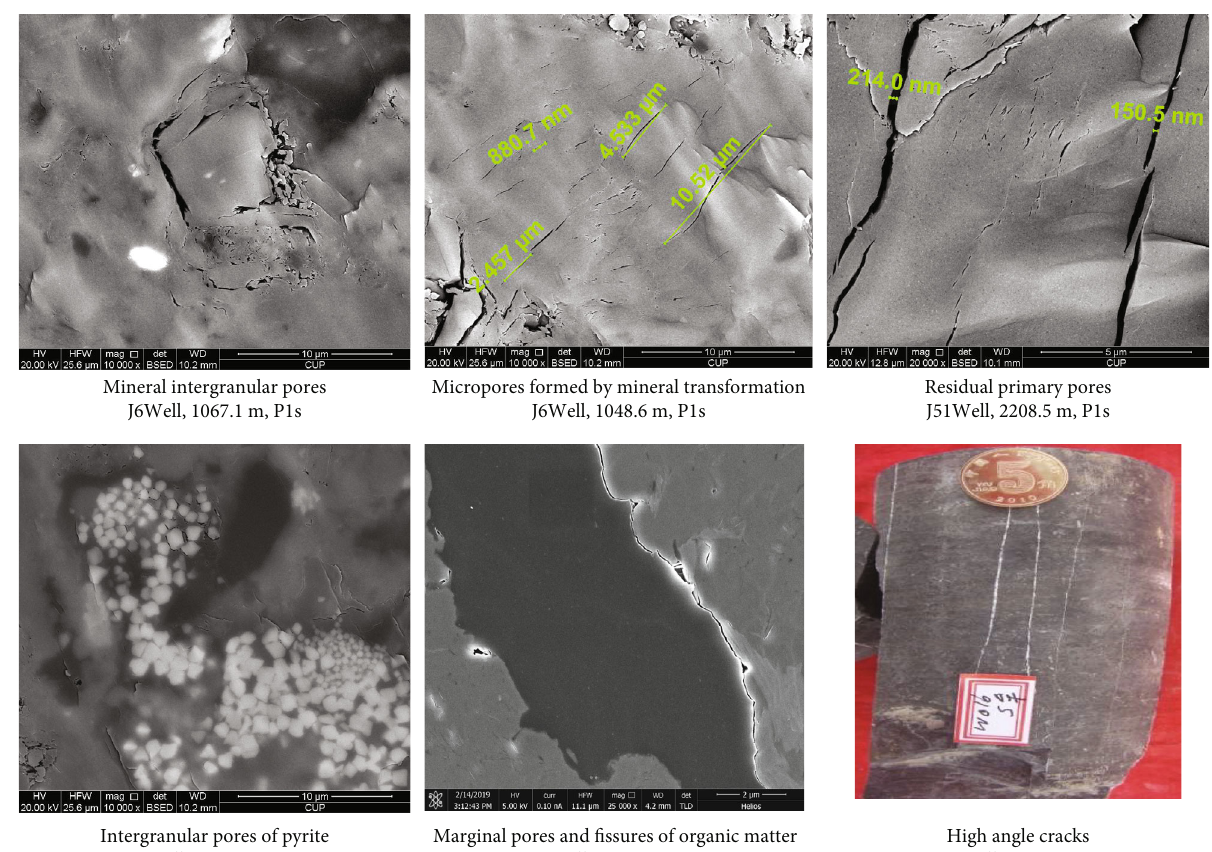
Figure 8: Scanning electron microscopy images of the